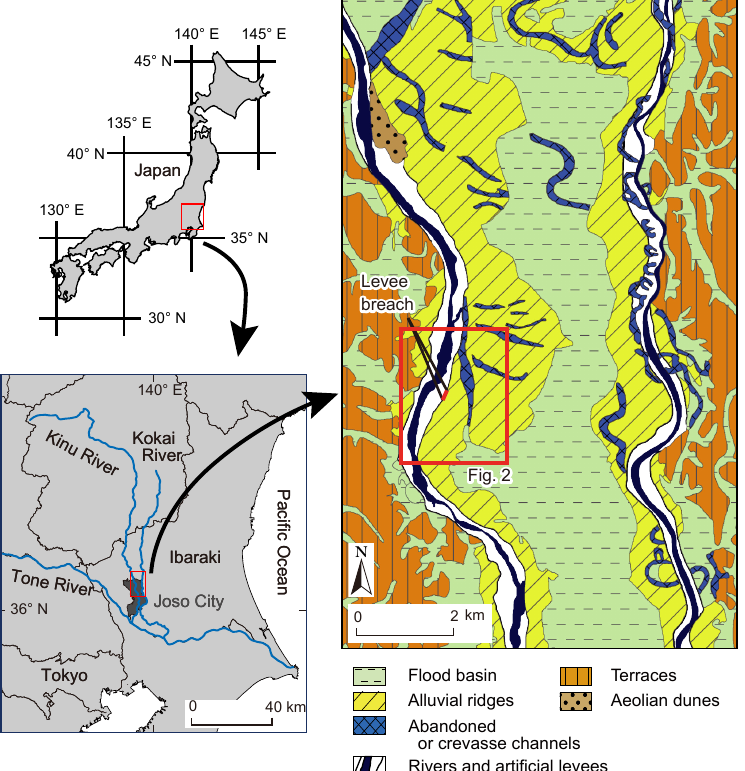
Figure 1. Location map of the city of Joso and the Kinu River, and geomorphic map showing the location of the levee breached during the 2015